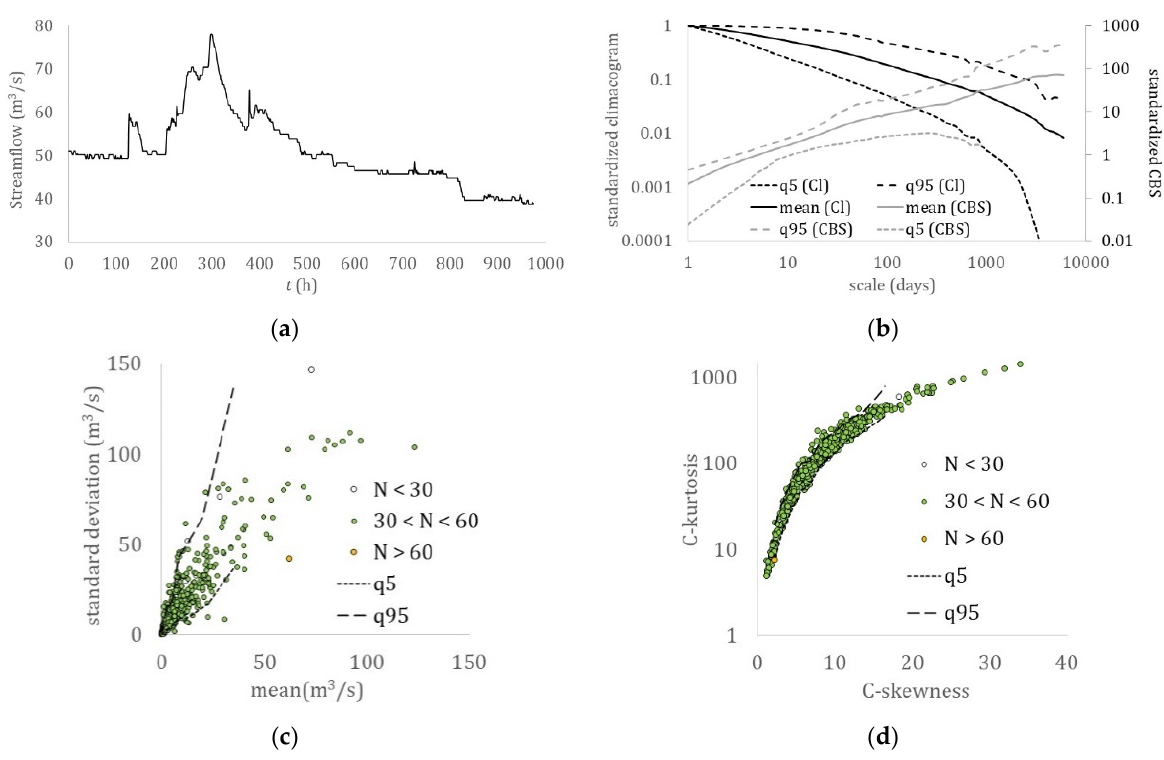
Figure 7. Streamflow: ( a ) hourly sample (Potomac River, USA); ( b ) climacogram and climacospectrum (mean, and 5% and 95% quantiles); ( c ) mean vs. standard deviation; ( d ) C-skewness vs. C-kurtosis.